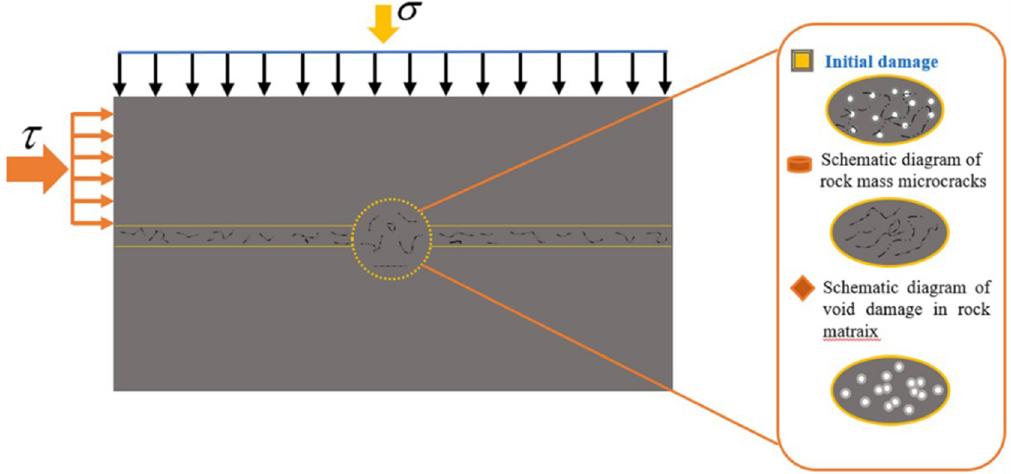
Fig 2. Schematic diagram of shear damage evolution for rock masses after considering initial